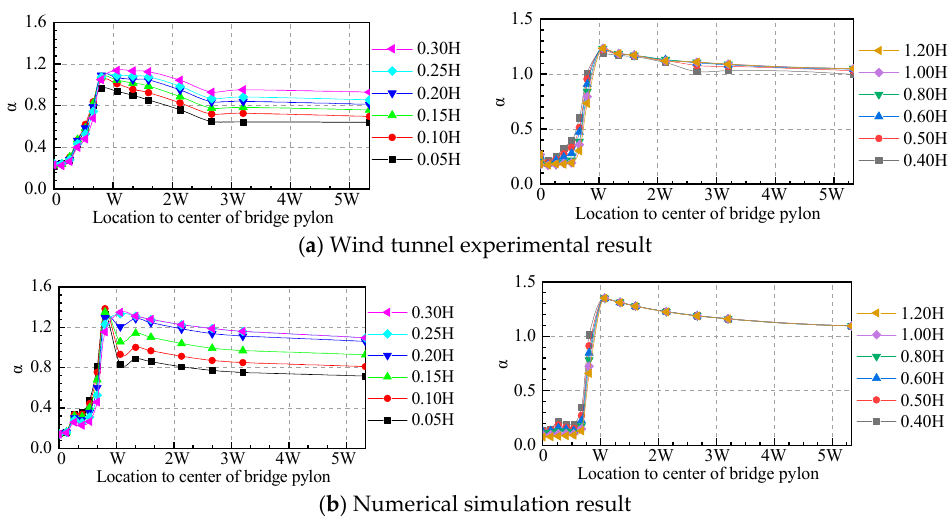
Figure 14. Wind speed coefficient at upstream main lane in C2 condition.